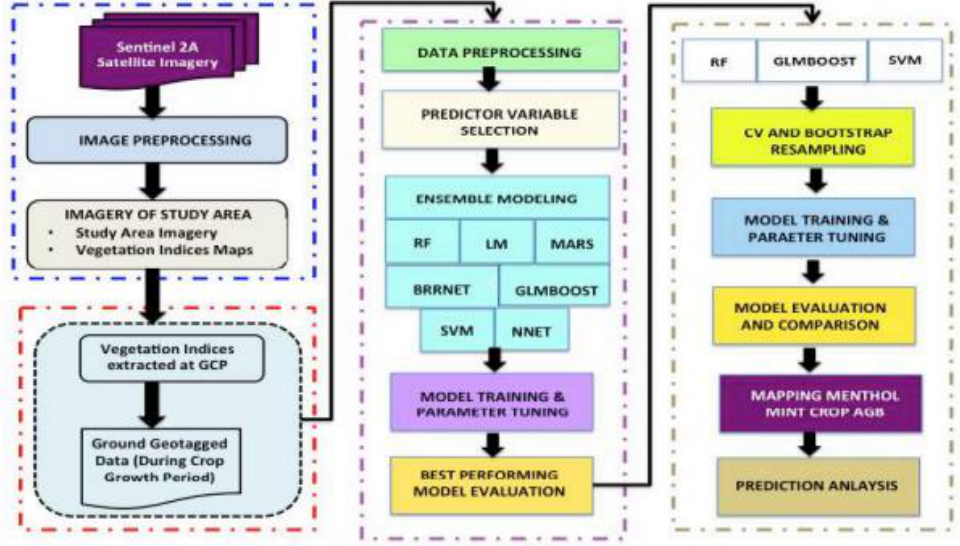
Figure 6. Schematic diagram of the